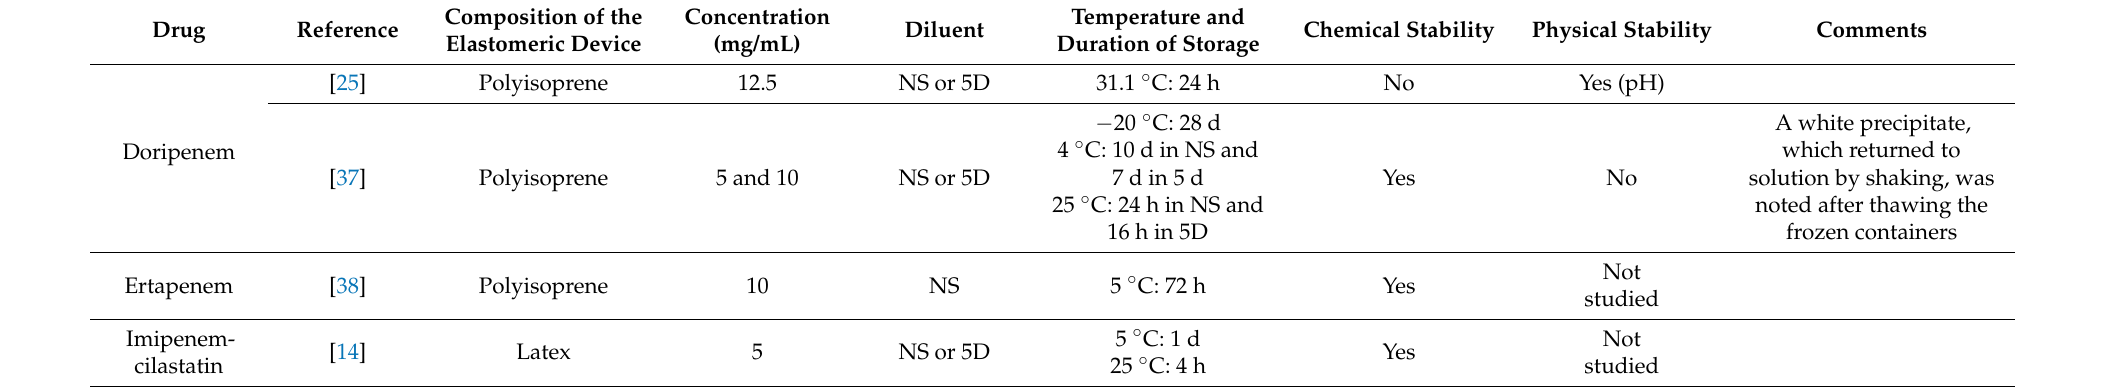
Table 3. Stability of carbapenems in elastomeric